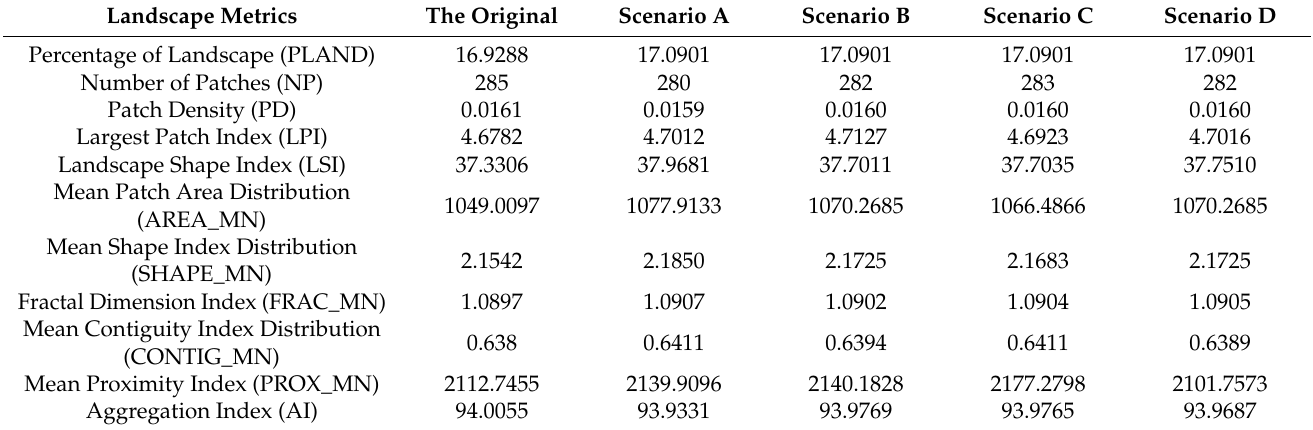
Table 4. Landscape metrics calculations results of spatial patterns of urban land